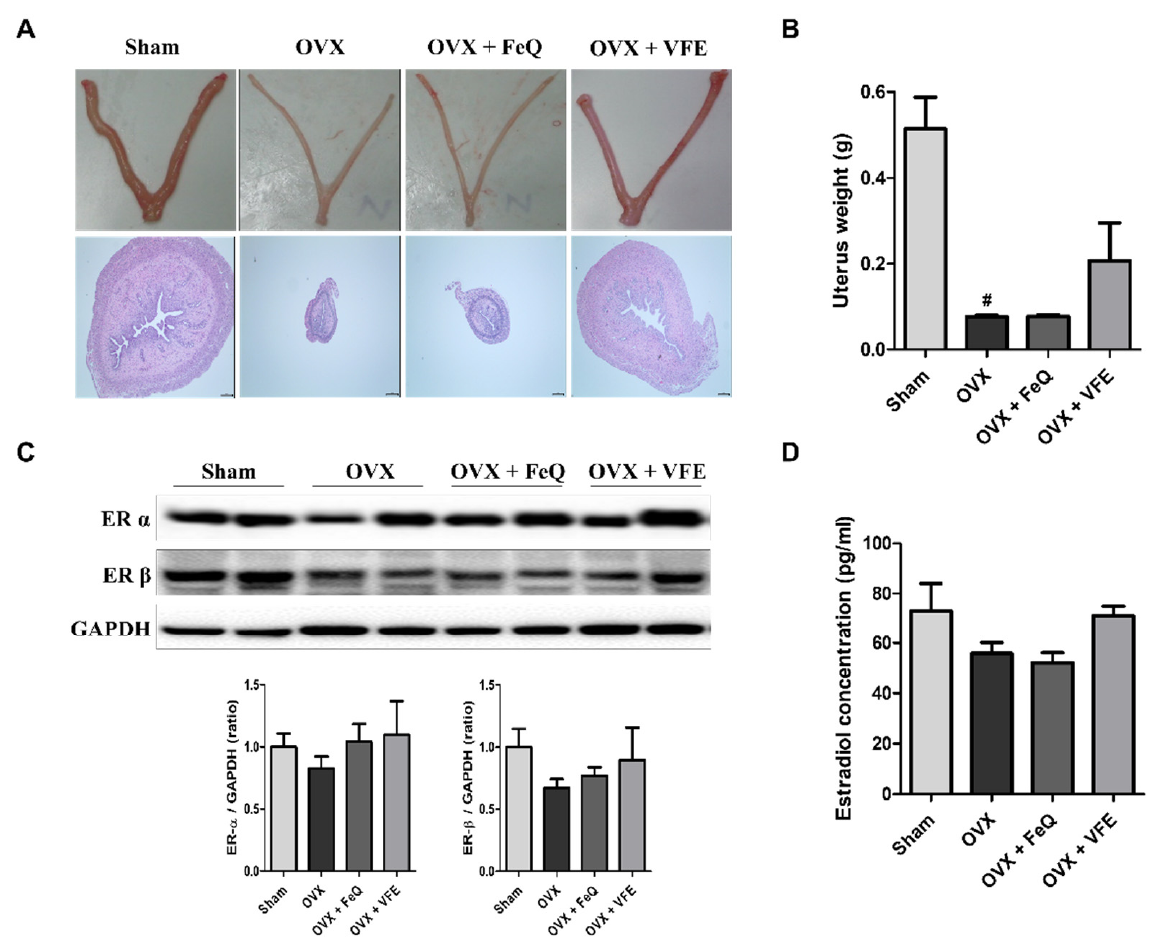
Figure 5. Estrogenic effect of VFE on the uterus of ovariectomized rats. ( A ) The uterus tissue and micrographs of H&E-stained samples (200 × ), ( B ) uterus tissue weight, ( C ) protein expression levels of estrogen receptor- α and receptor- β , and ( D ) plasma estradiol level. The data are expressed as means ± SEM. Statistical significance was evaluated and determined by a one-way analysis of variance (ANOVA), followed by the Tukey’s posthoc test. # p < 0.05 vs. sham.